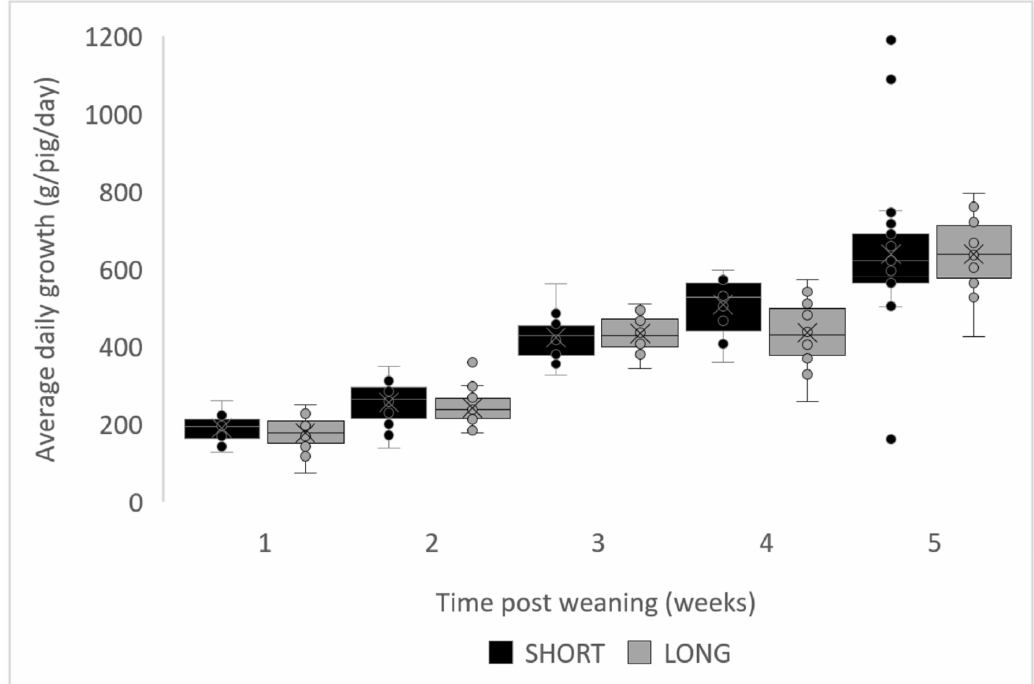
Figure 2. Average daily gain for SHORT (black, 8 h light and 16 h dark) and LONG (grey, 16 h light and 8 h dark) groups ( p treatment × p week = 0.096, P treatment = 0.602, p week ≤ 0.001). Boxplot with jitter for each of the weekly (1–5 weeks post-weaning) timepoints. Piglets of each pen were weighed at the end of every week. The average weight was calculated for each pen. This weight was subtracted from the previous average (or starting) weight and divided by 42 (6 pigs, 7 days) to get the ADG. Pen data are provided for each timepoint (circles). Median values are given by the horizontal line and means are indicated by the “X”. The first and third interquartile ranges are given in by the lower and upper border of the boxplot. The minimum and maximum values are given by the whiskers. Outliers are shown outside of the